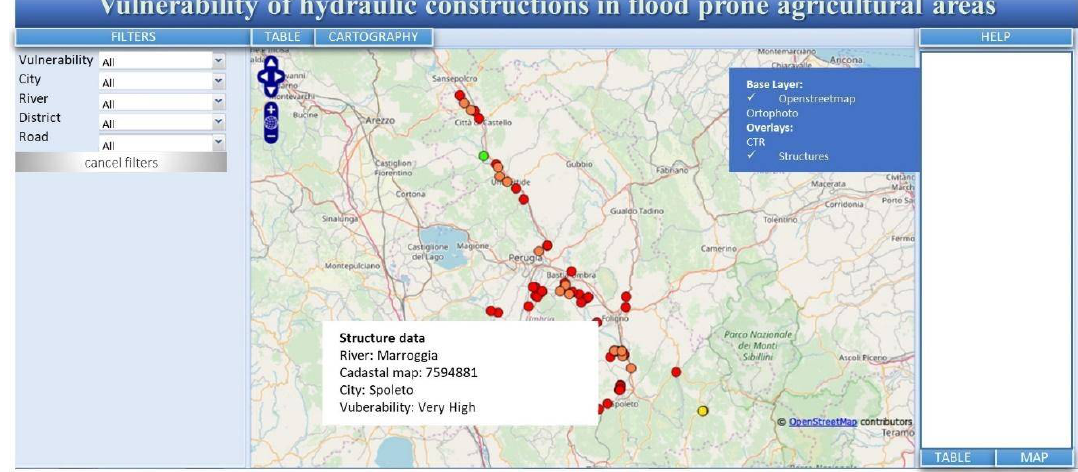
Figure 11. Map visualization of studied bridges.